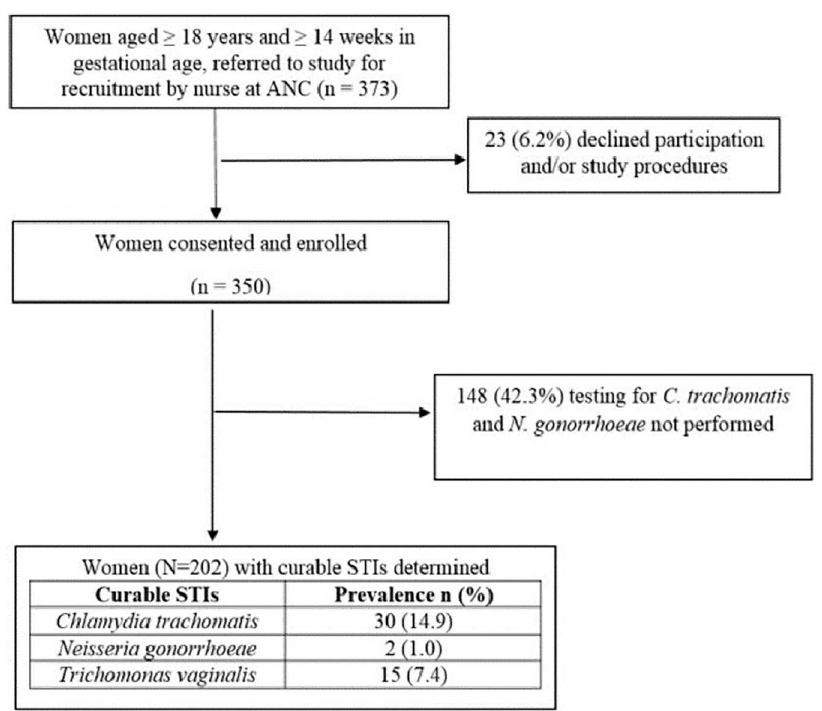
Fig 1. Flow chart of women attending antenatal care clinic at Kilifi County Hospital invited to participate in the study, June- September2015